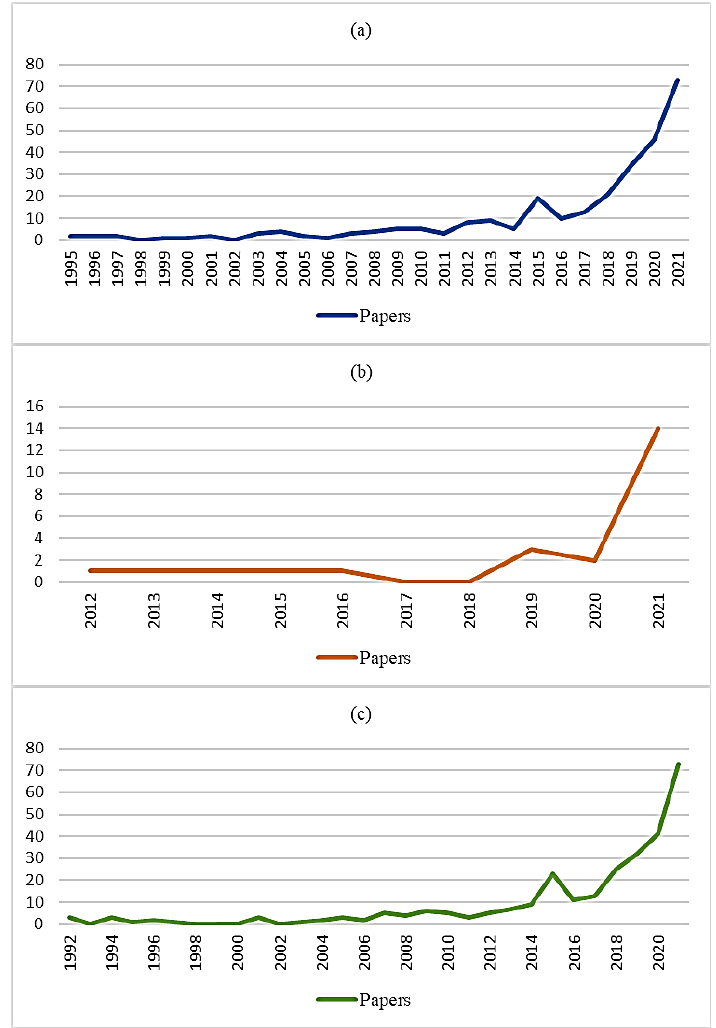
Figure 5. No of papers per year for (a) upstream, (b) midstream and (c)